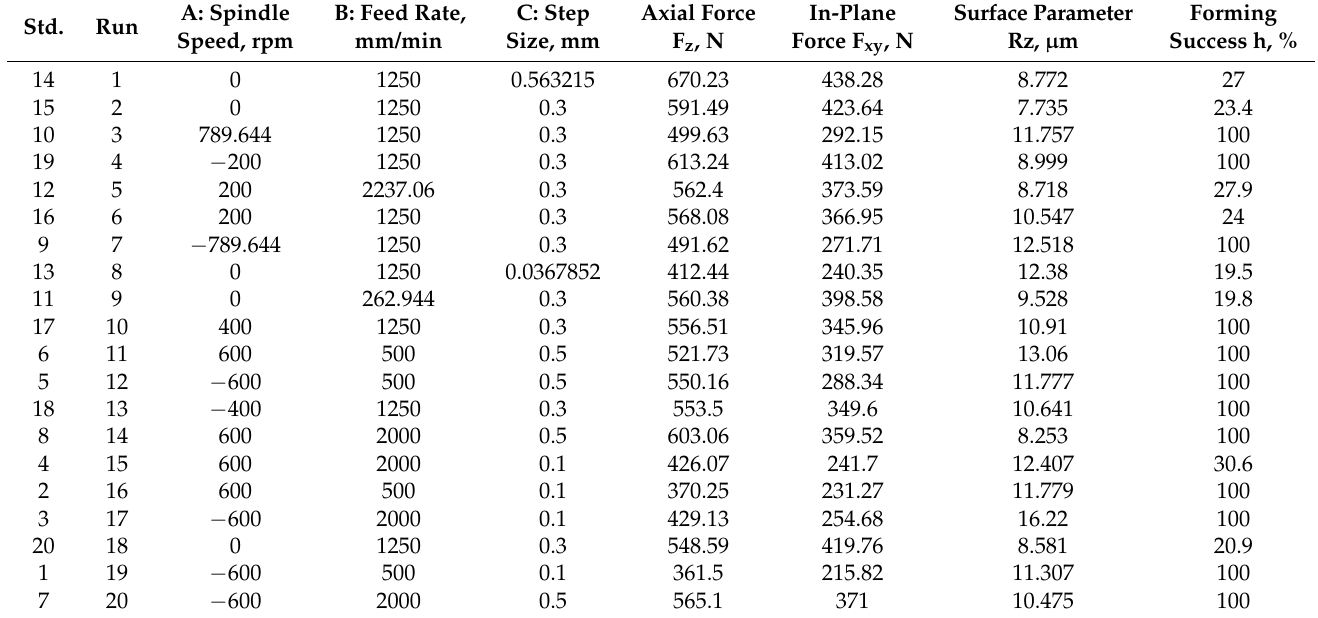
Table 4. Results of the SPIF forming.